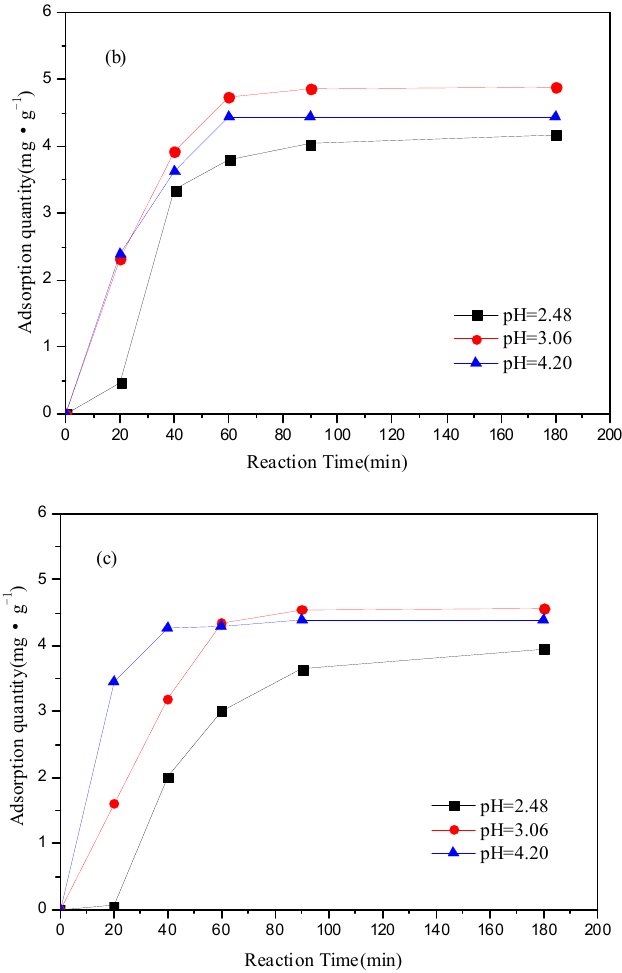
Figure 2. Effect of initial pH (2.48, 3.06 and 4.20) on the adsorption capacity of the three layers of soil: ( a ) top layer of loess soils; ( b ) core layer of loess soils and ( c ) subsoil layer of loess soils. (4 mg of soil, initial concentration of Fe 3+ was 300 mg·L − 1 , 25 °C).